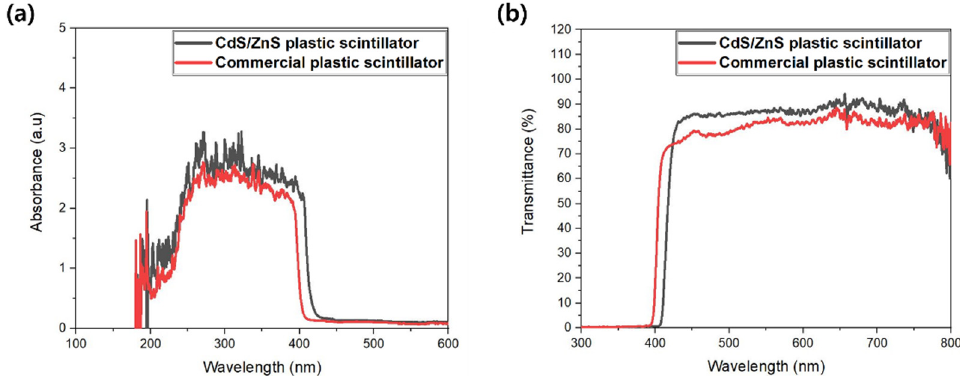
Figure 3. Absorbance ( a ) and transmittance ( b ) of commercial plastic and CdS/ZnS-loaded plastic scintillator fabricated with a thickness of 50